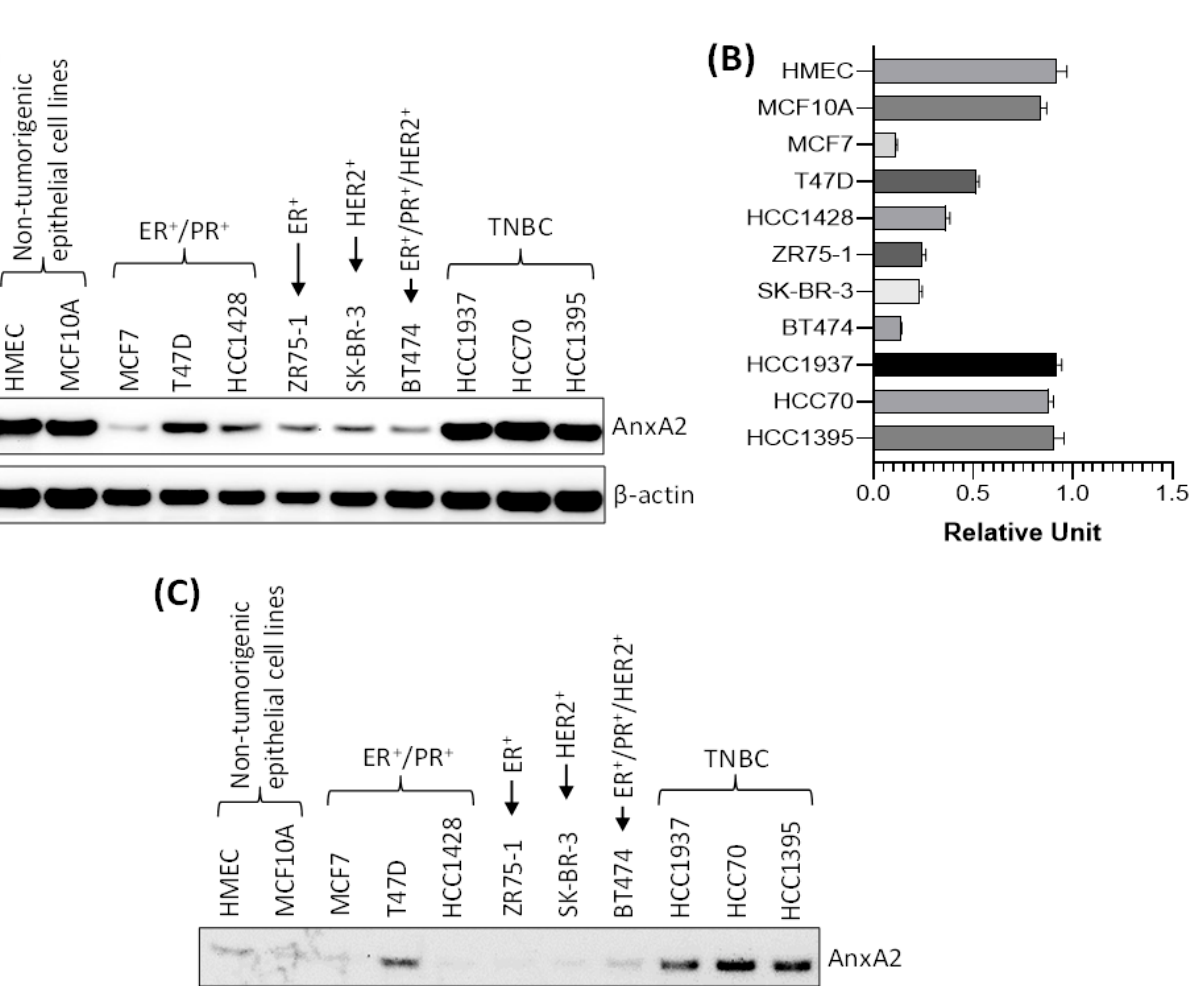
Figure 4. Expression and secretion of AnxA2 in breast cancer cell lines. ( A ) AnxA2 protein expression was analyzed by immunoblotting in breast cancer cell lines and non-tumorigenic mammary epithelial cell lines. The membrane was stripped and reprobed with anti- β -actin antibody for loading control. ( B ) Bar chart showing the densitometric analysis (using ImageJ software) of AnxA2 bands of the immunoblot of panel A. Intensity of AnxA2 bands was normalized by β -actin loading control. Each bar represents the mean ± SE of three independent experiments. ( C ) Non-tumorigenic or breast cancer cells (6 × 10 5 ) were plated in 100mm Petri dish for overnight and then switched to their respective serum free medium. After 24 h, AnxA2 was immunoprecipitated from the medium using anti-AnxA2 antibody and expression of AnxA2 secretion was analyzed by immunoblot analysis. Uncropped Western Blots of ( A ) and ( C ) are available in Figure S2.